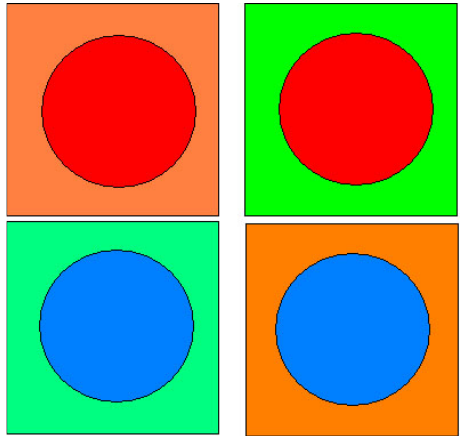
Fig. 3. The impact of simultaneous contrast on color perception. The differences between the colored spots on the background of complementary colors are more